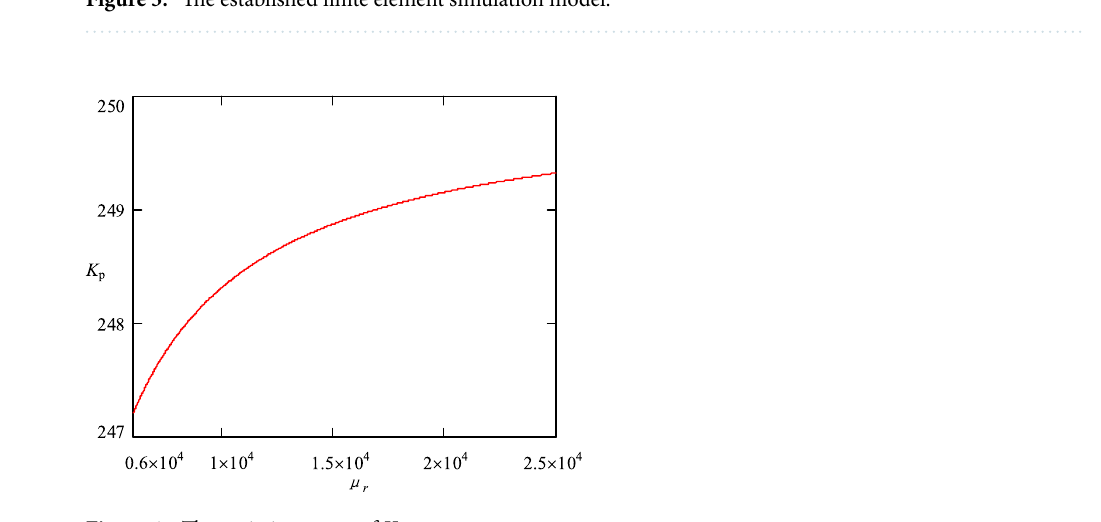
Figure 4. The variation curve of K p